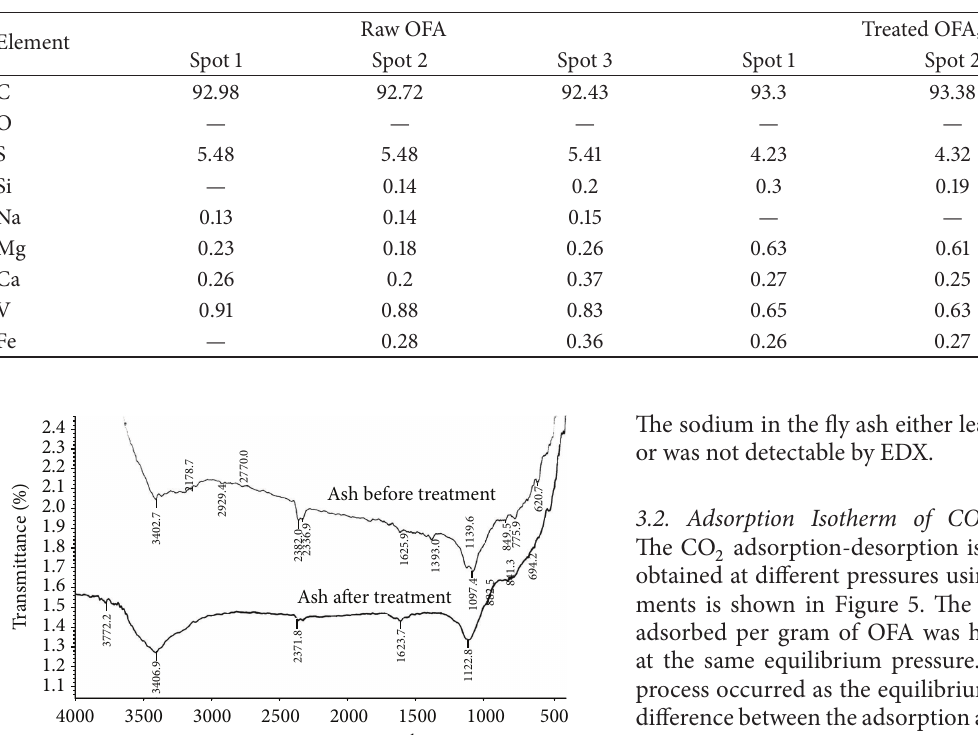
Table 1: Surface properties of OFA measured by N 2 adsorption analysis at 77 K.